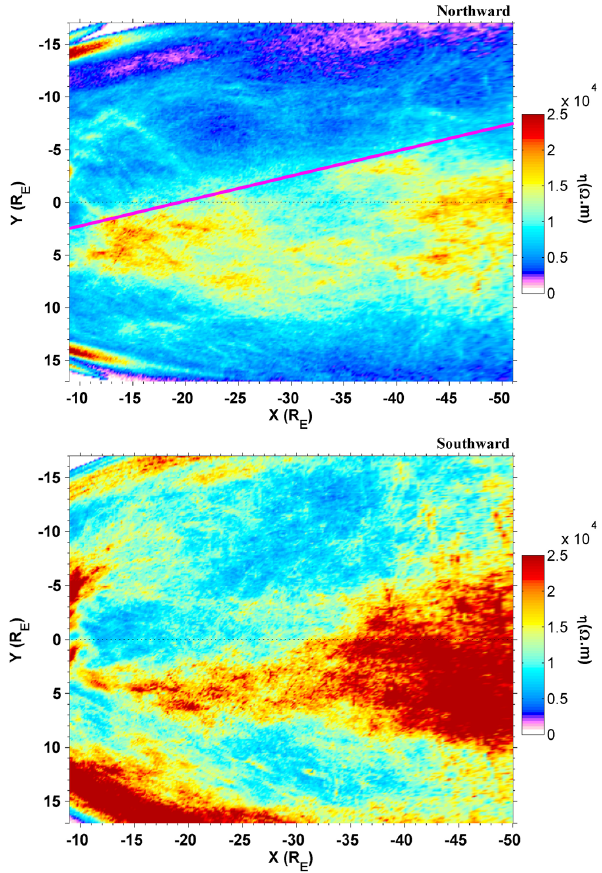
Fig. 6. Time averaged resistivity distribution in the z = 0 plane. Shown in the top panel is the northward IMF interval, T N + 30 to T N +360min in the simulation. The southward IMF interval, 90 to 270min, is shown in the bottom panel. A magenta line has been drawn that corresponds to the edge of the region on high average resistivity on the dusk